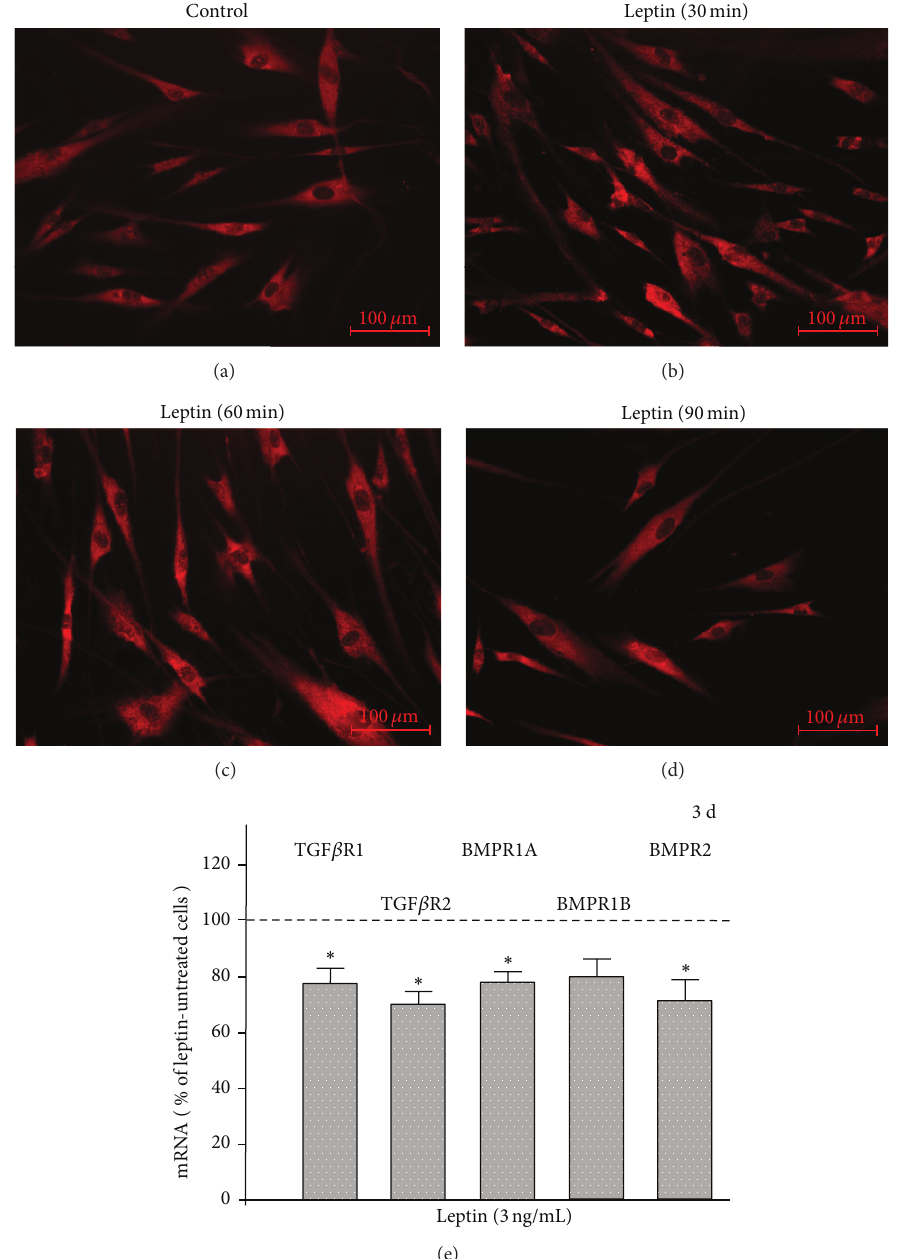
Figure 4: Effect of leptin (3ng/mL) on the nuclear translocation of NF 𝜅 B p65, as examined by immunofluorescence ((a)–(d)). Experiments were performed in triplicate and repeated twice. Untreated cells served as control. Images from one representative donor are shown. Effect of leptin (3ng/mL) on TGF 𝛽 R1, TGF 𝛽 R2, BMPR1A, BMPR1B, and BMPR2 mRNA at 3d (e). Untreated cells served as control. Mean ± SEM ( 𝑛 = 18 ); ∗ significantly ( 𝑃 < 0.05 ) different from